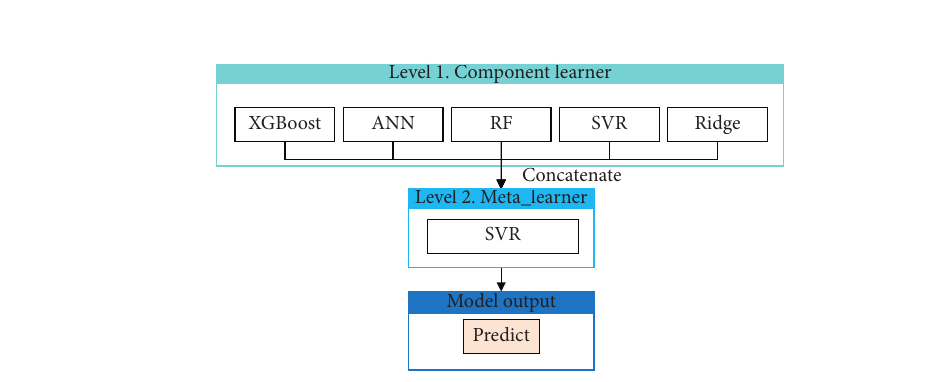
Figure 6: Construction of the integration model.